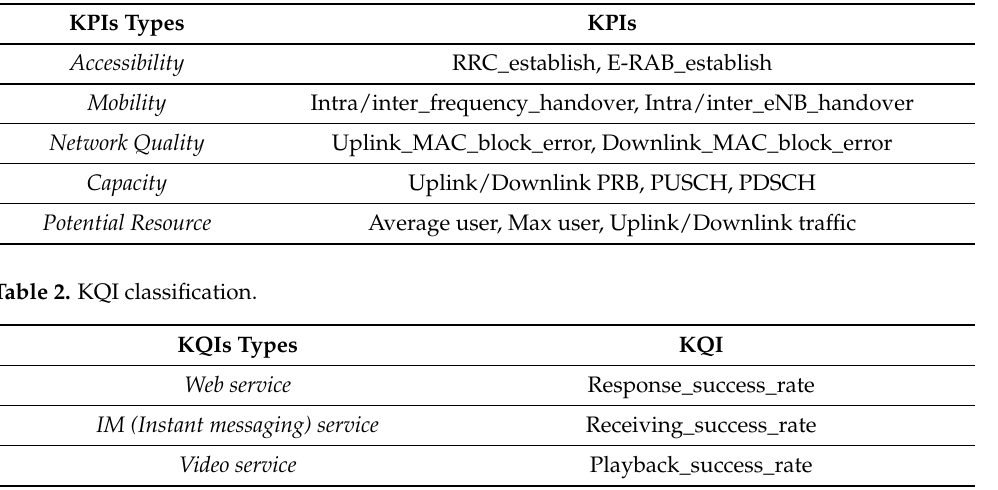
Table 1. KPI classification.